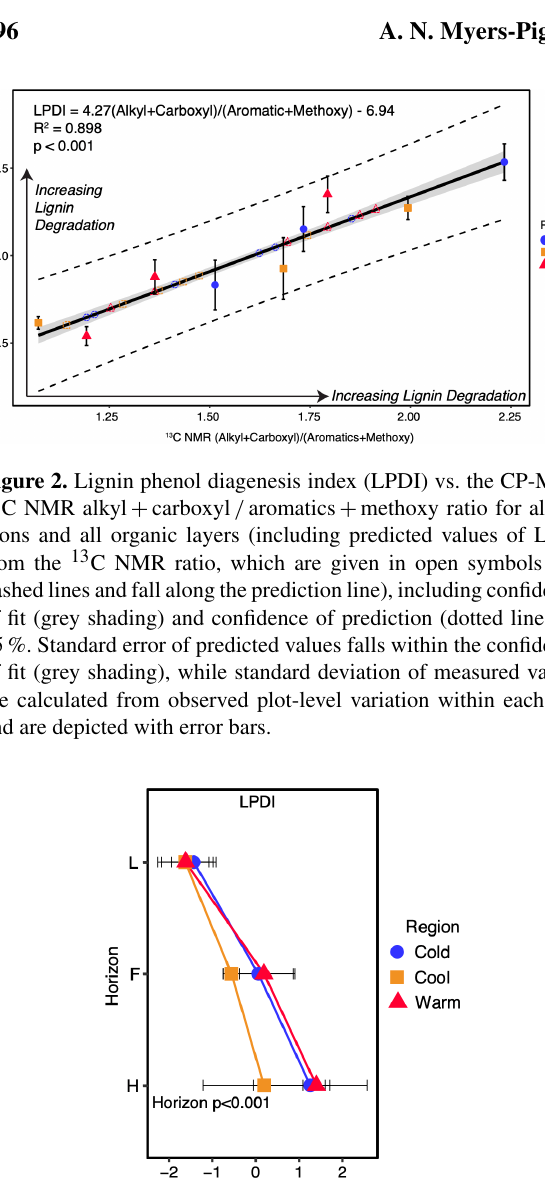
Figure 3. The lignin phenol diagenetic index (LPDI) increases with organic layer depth with individual horizons designated (L, F, and H). The actual p value for the horizon (H), region (R), or horizon x region (HXR) significance is reported with significant values ( α = 0 . 05) in bold. LPDI is a unitless